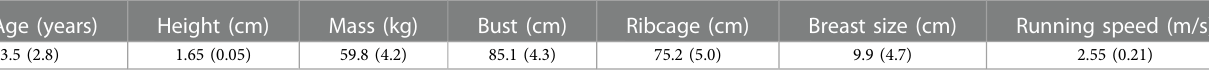
TABLE 1 Participant information including age, height, mass, bust, rib cage, calculated breast size and running